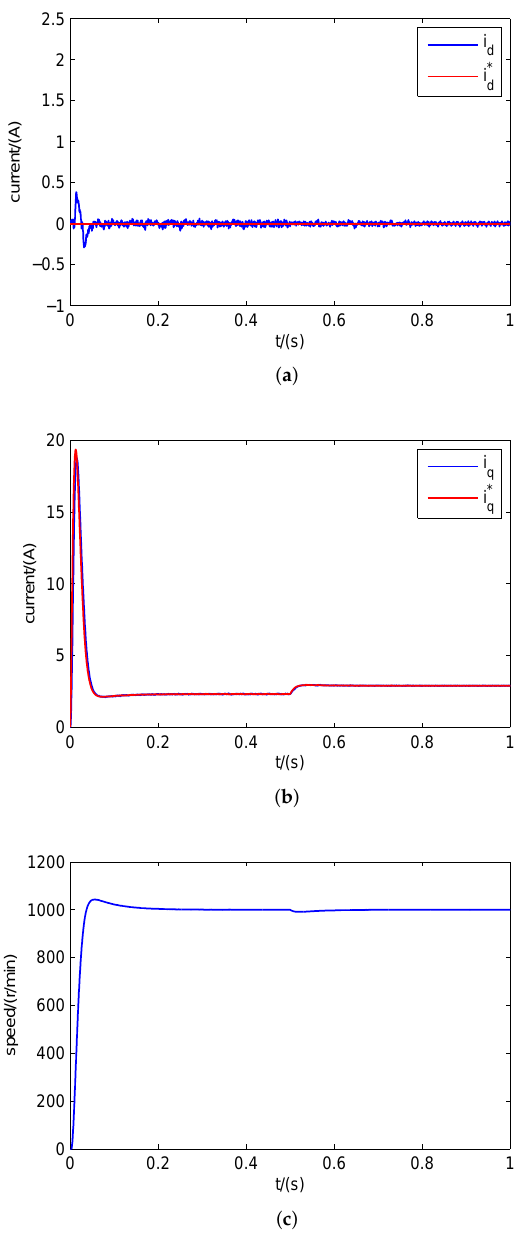
Figure 4. Simulation results with the proposed method: ( a ) d-axes current; ( b ) q-axes current; and ( c ) speed